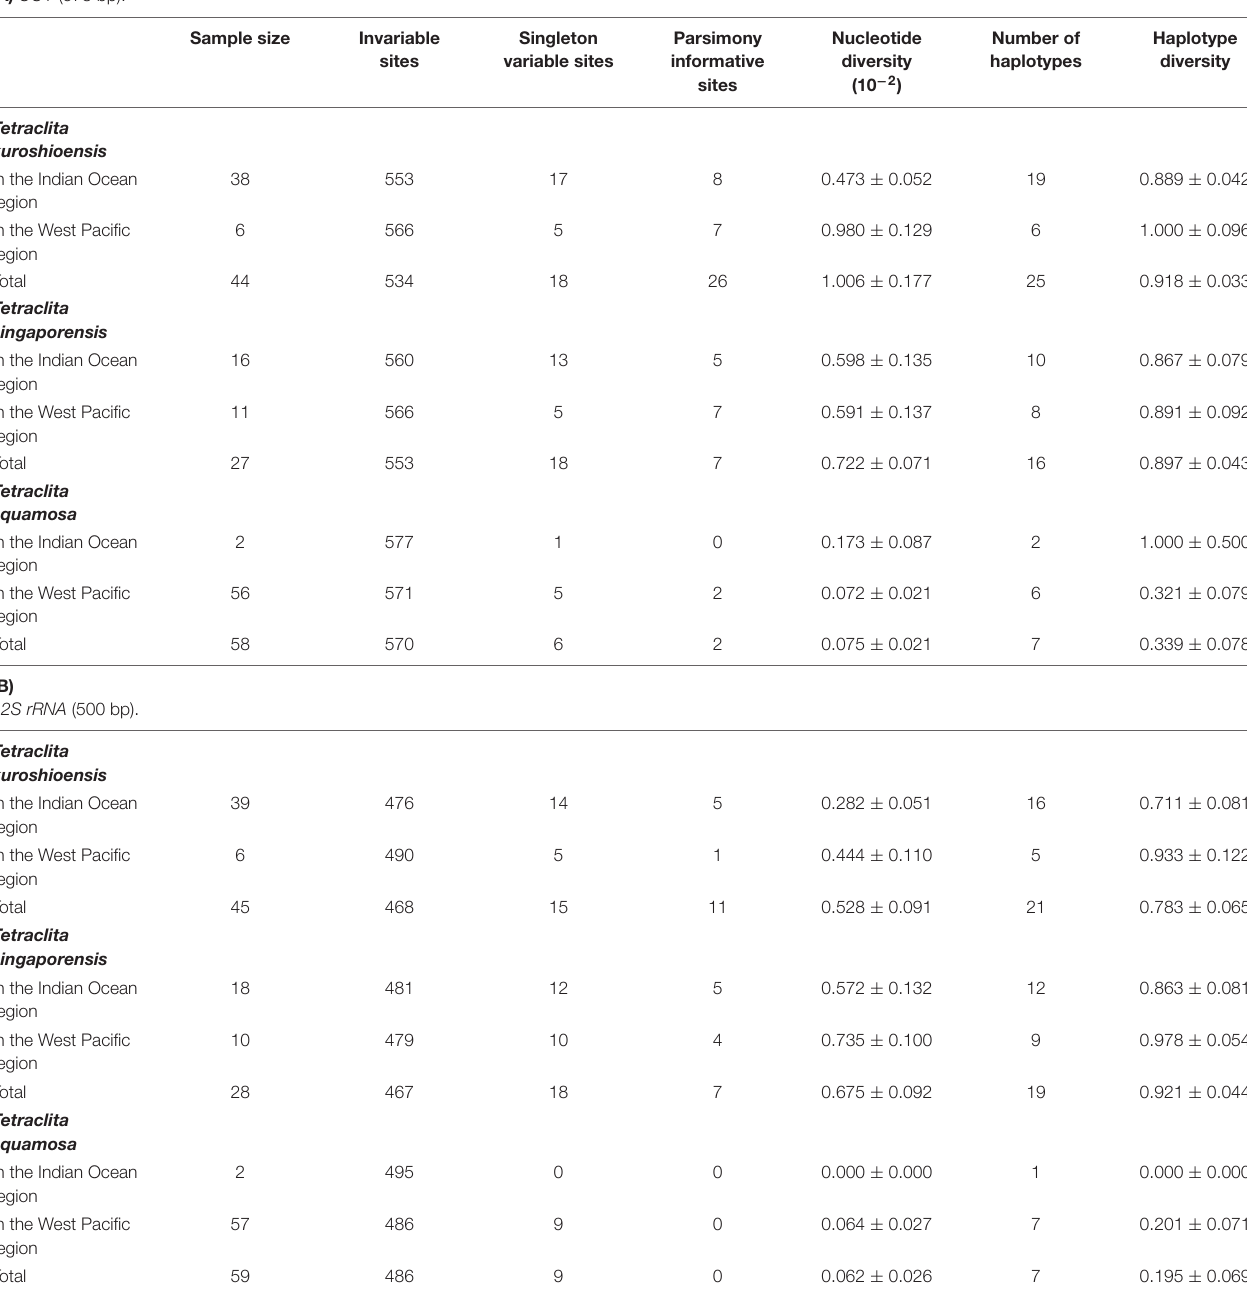
TABLE 3 | Genetic diversity of Tetraclita spp. in Thailand. (A) CO1 (578